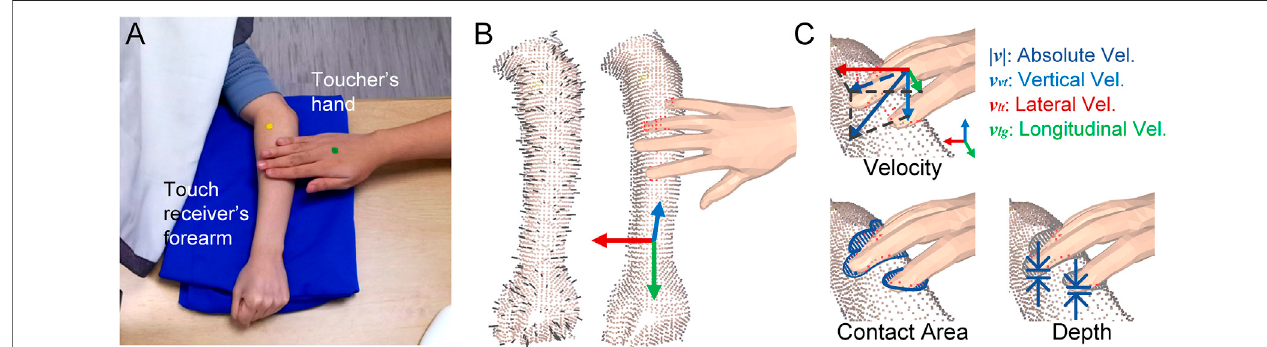
FIGURE 2 | De fi nition of contact attributes. (A) Color image from video recorded by depth camera. Two color markers were placed on the toucher ’ s hand and the receiver ’ s forearm respectively to support motion tracking. (B) 3D forearm point cloud and hand mesh. Short black line segments represent the norm vector of arm points; red points on the forearm represent the region contacted by the hand. In the arm coordinate, the vertical axis (blue) is designated along the vertical direction pointing right upward, the longitudinal axis (green) is parallel with the arm direction from elbow to wrist, and the lateral direction is perpendicular to the two axes pointingtothe internalside ofthe forearm. (C) Sixtime-series attributes includeabsolutevelocity, whichistheabsolutevalueofspatial contact velocity; threeorthogonal velocity components corresponding to the three axes of the arm coordinate; contact area, which is the overall area on the forearm being contact; and the indentation depth as the average depth applied on the forearm by the hand.